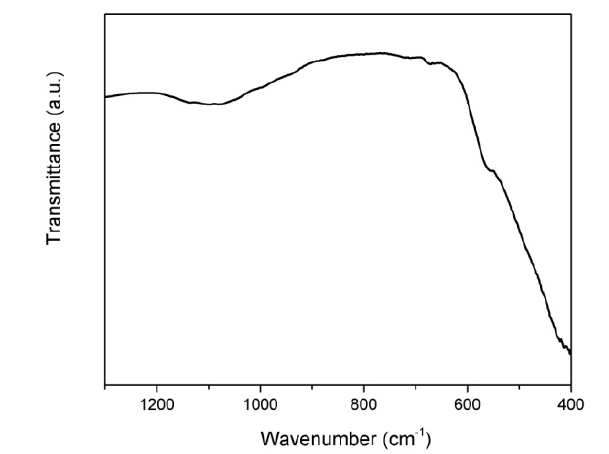
Figure 3 – FTIR spectrum of the sample prepared without using NaOH Рис . 3 – FTIR спектра образца , подготовленного без